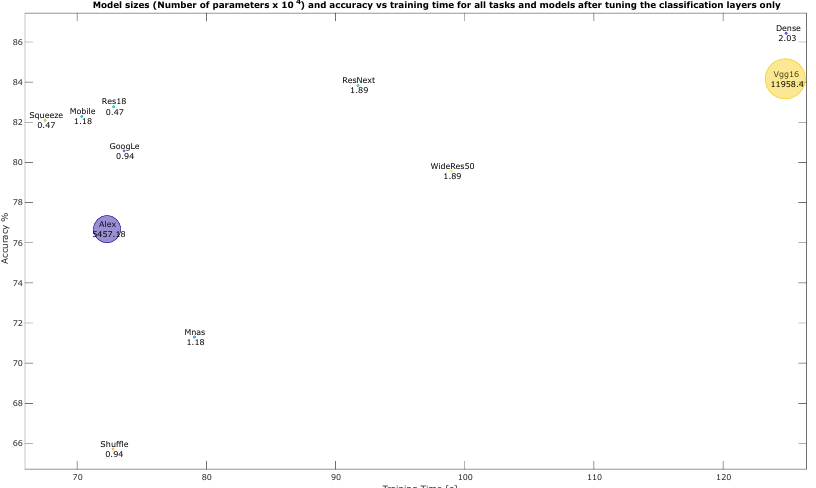
Figure 6. Model sizes and accuracy vs. training time for all tasks and models after fine-tuning the classifier layer